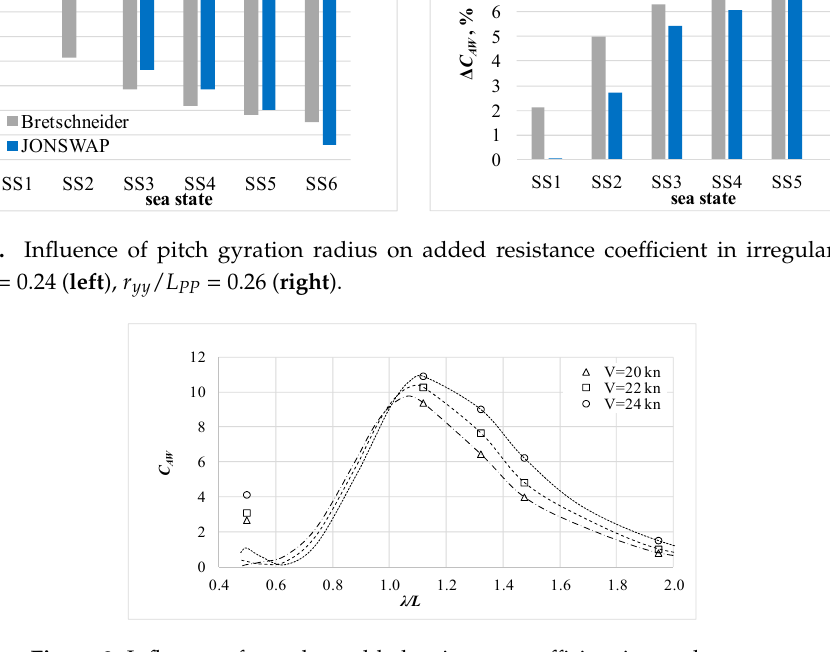
Figure 9. Influence of speed on added resistance coefficient in regular waves.